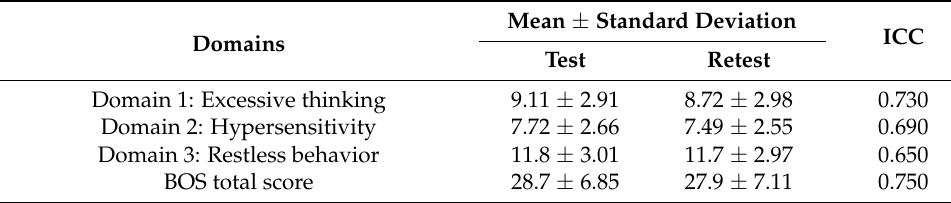
Table 4. Intraclass correlation coefficients (ICC) of the BOS ( n =